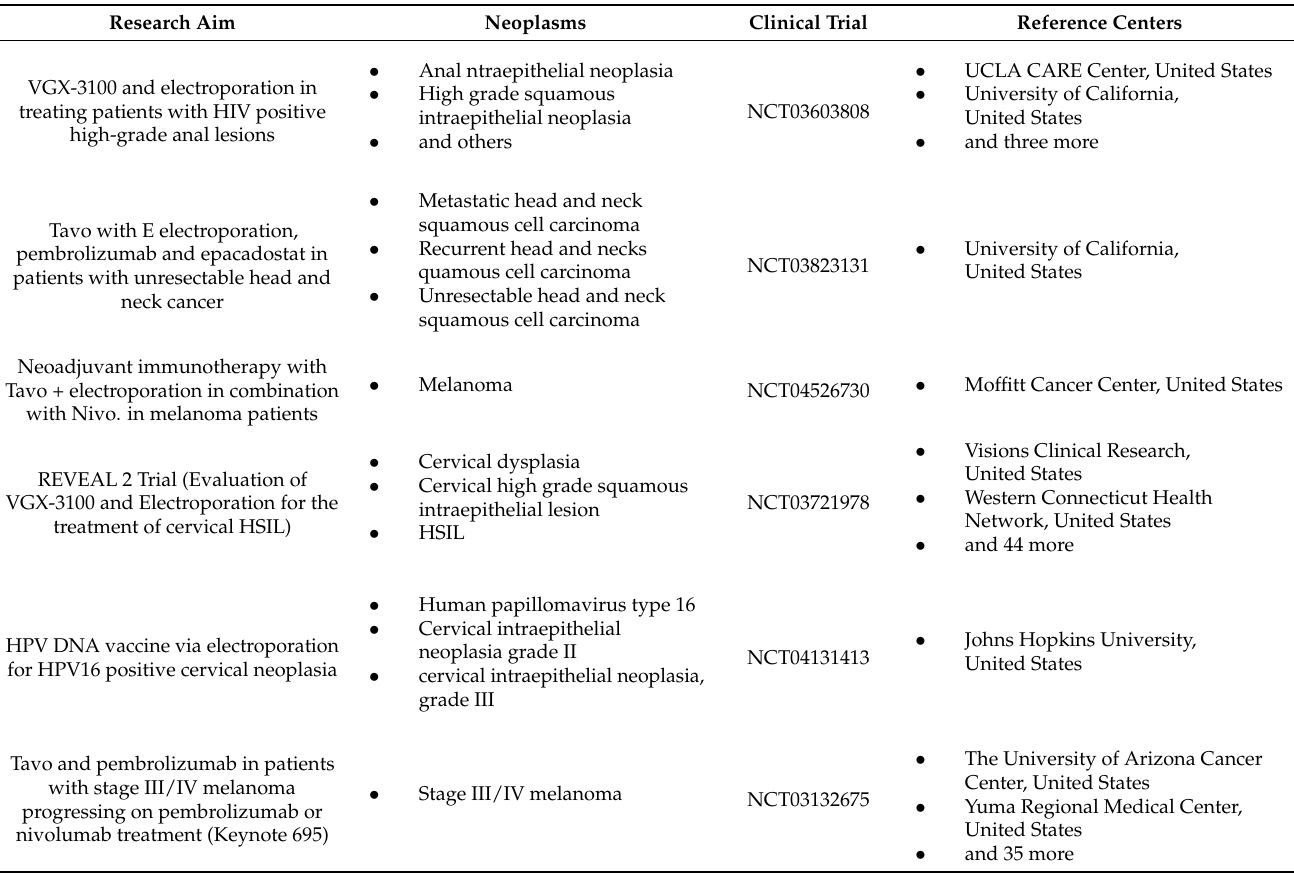
Table 1. Current human clinical trials in the recruitment phase for electrochemotherapy, electrotransfer gene and combi- nations. Accessed on: 1 June 2021. Link: https://clinicaltrials.gov/ct2/results?term=electroporation+NOT+irreversible+